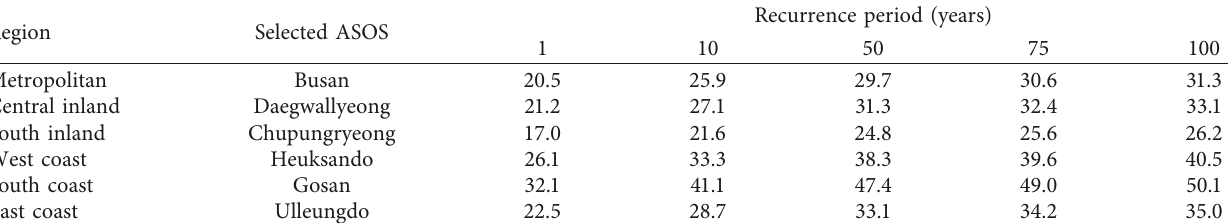
Figure 7: Gumbel distribution-based estimated distributions of daily maximum wind speeds for the recurrence periods of 1 year (a), 50 years (b), and 100 years (c). Table 2: Gumbel distribution-based estimations of daily maximum wind speeds (m · s − 1 ) with recurrence periods of 1, 10, 50, 75, and 100